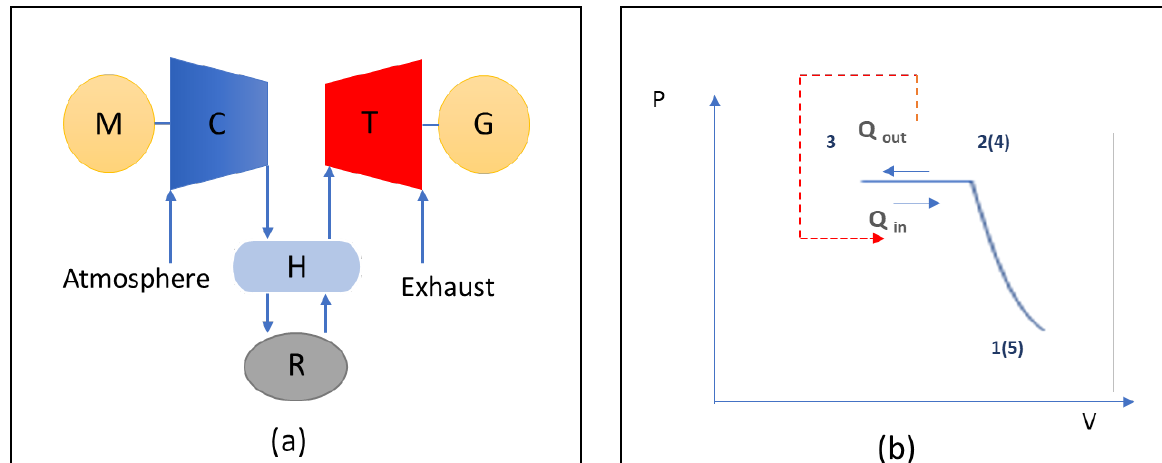
Figure 6. A-CAES system: ( a ) A-CAES system diagram; ( b ) A-CAES P-V diagram, adapted with [4,5]. To improve the performance of an A-CAES system, ejector technology was employed. The A-CAES system with an ejector increased power output from 31.10 MW to 32.81